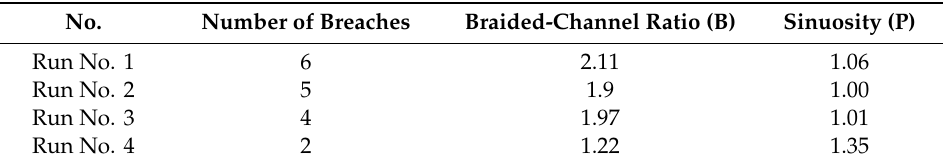
Table 6. The parameters of the braided